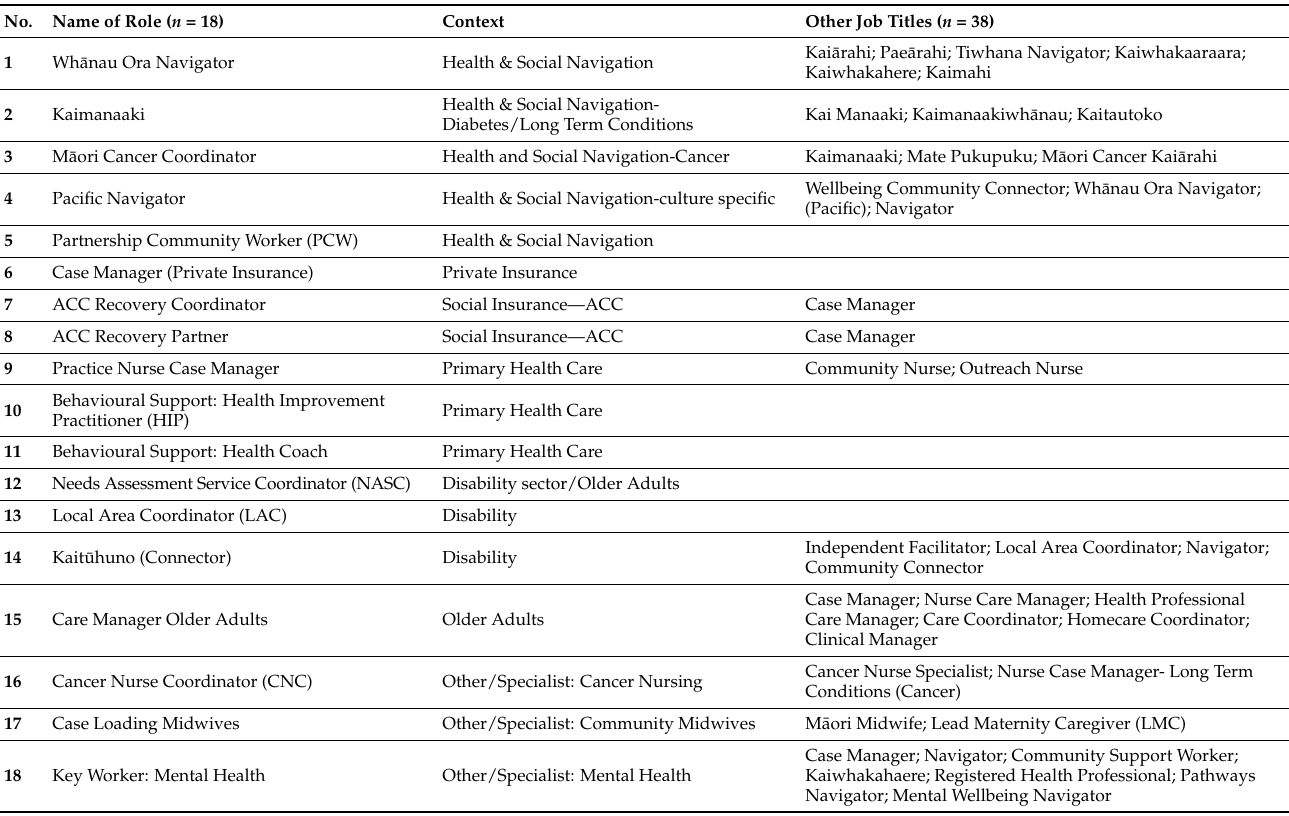
Table 3. Summary of Roles and Job